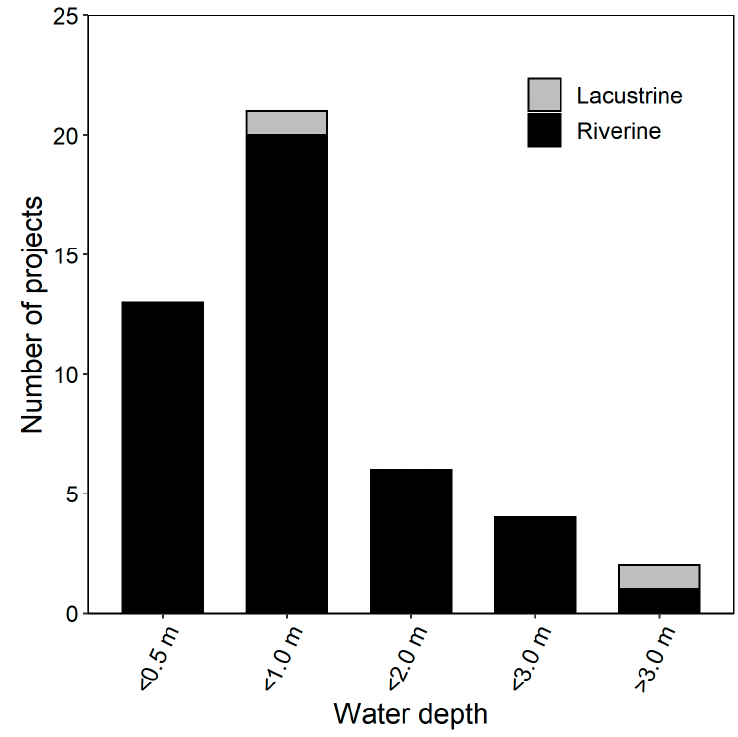
Figure 5. Water depths (m) and habitat types (“lacustrine” vs. “riverine”) represented by the rocky habitat maintenance projects in our review with reported water depths ( n = each water depth category represents the average or maximum water depth reported (pre- or post-maintenance)).